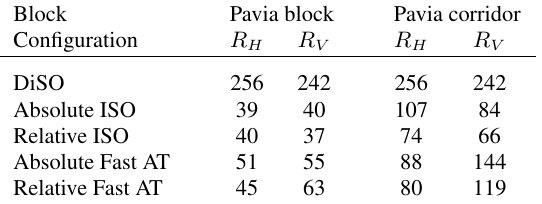
Table 7: RMSE (mm) of ChPs of selected Pavia block and Pavia corridor